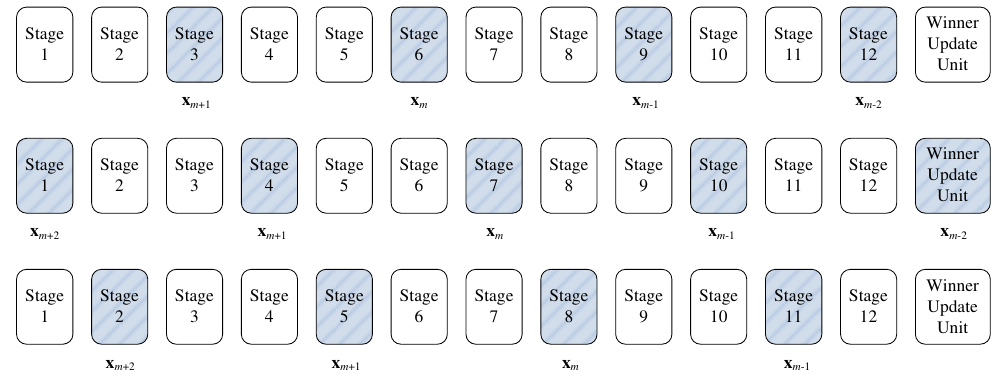
Figure 5. The codeword swapping operations for k = 2 : ( a ) Loser is at stage i , ( b ) Loser is at stage i − 1 , ( c ) Loser is at stage i − 2